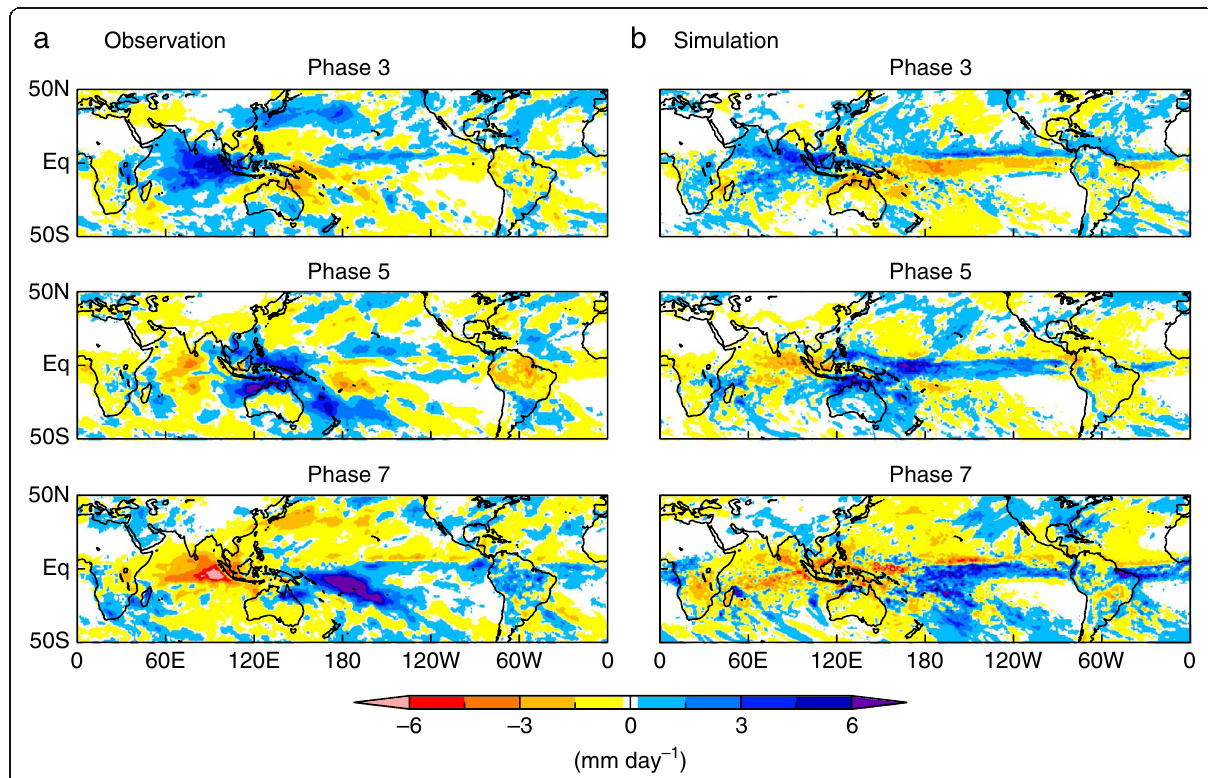
Fig. 7 Precipitation anomaly composites for different MJO phases. a Observed 1° daily product version 1.2 by the Global Precipitation Climatology Project (Huffman et al. 2001), and b simulation using NICAM. The average number of days from the initial dates of the simulations are 16 days (phase 3), 25 days (phase 5), and 28 days (phase 7). Resolution of the simulation output is lowered to 1° mesh to equal the resolution of the observational data set. Anomalies are calculated as deviations from 40-day mean values in each case. After Fig. 2 of Miyakawa et al.